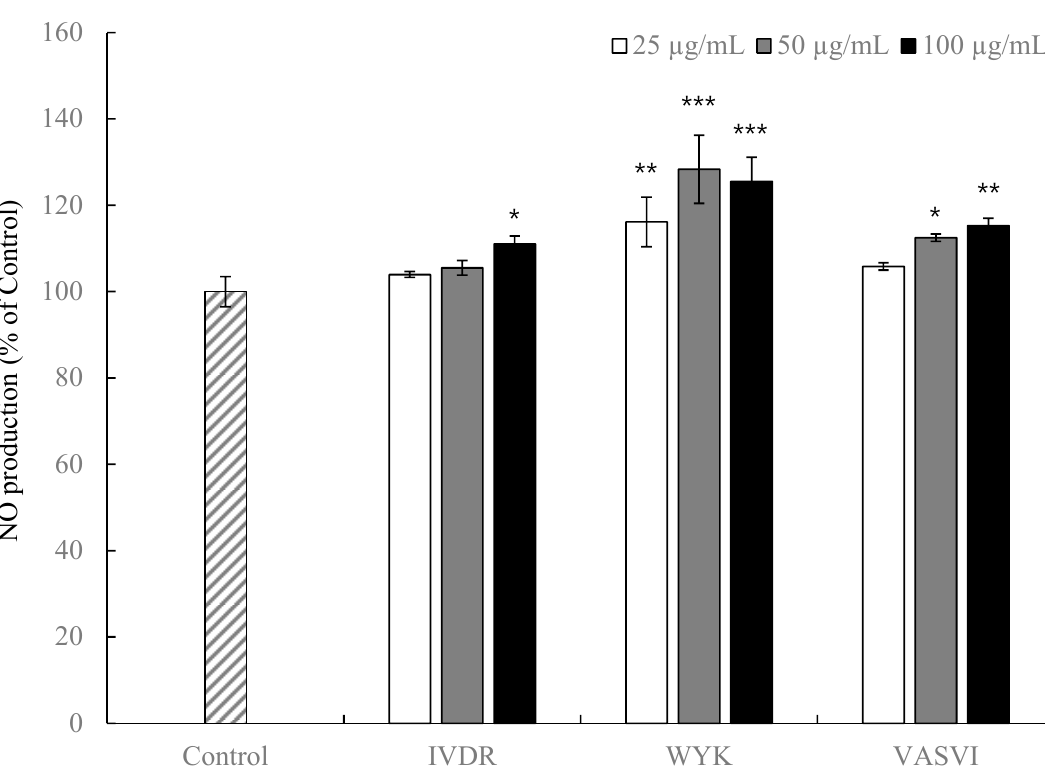
Figure 1. Induction of NO production by the peptides. The HUVECs were treated with various concentrations ( µ g / mL) of the peptides for 3 h. The values are means ± SD of triplicate experiments. * p < 0.05, ** p < 0.01, *** p < 0.001 as compared to control.